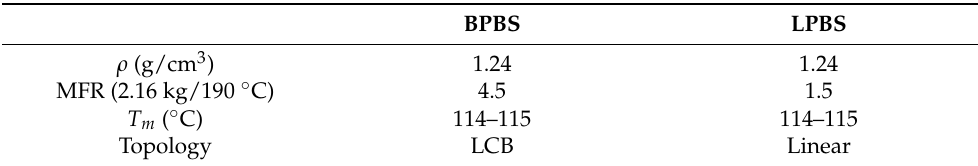
Table 1. Bionolle™ branching polybutylene succinate (BPBS) and linear polybutylene succinate (LPBS) grades